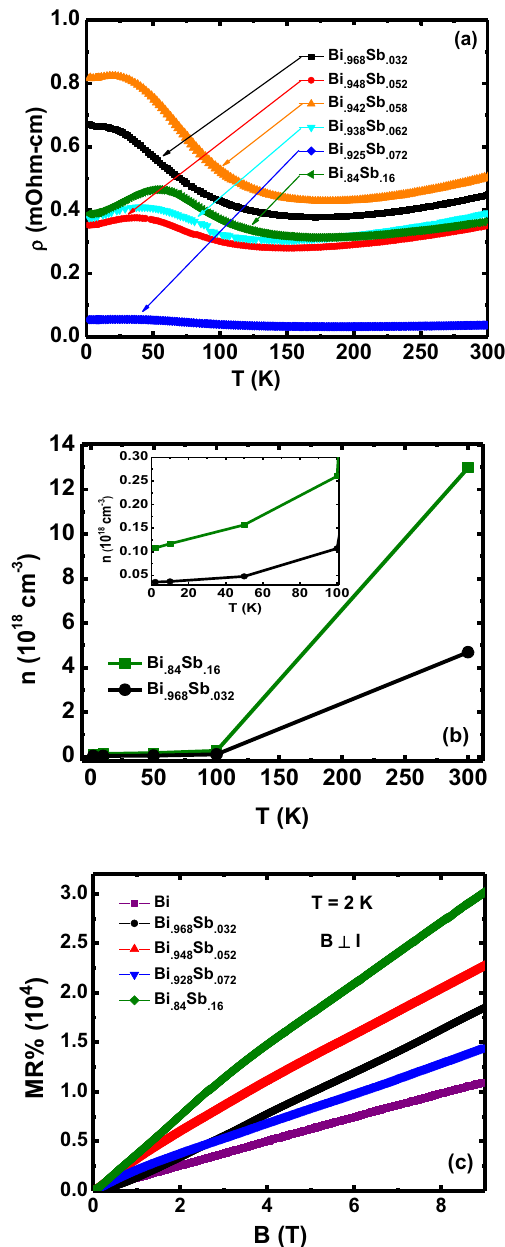
Figure 1. (Color online) ( a ) Resistivity ρ vs temperature T for Bi 1 − x Sb x . ( b ) The carrier density n versus T for x = 0.032, 0.16 samples. Inset shows n(T) for T < 100 K. ( c ) Transverse magneto resistance MR vs B at T = 2 K for Bi 1 − x Sb x . The MR for all x is positive and linear at high B